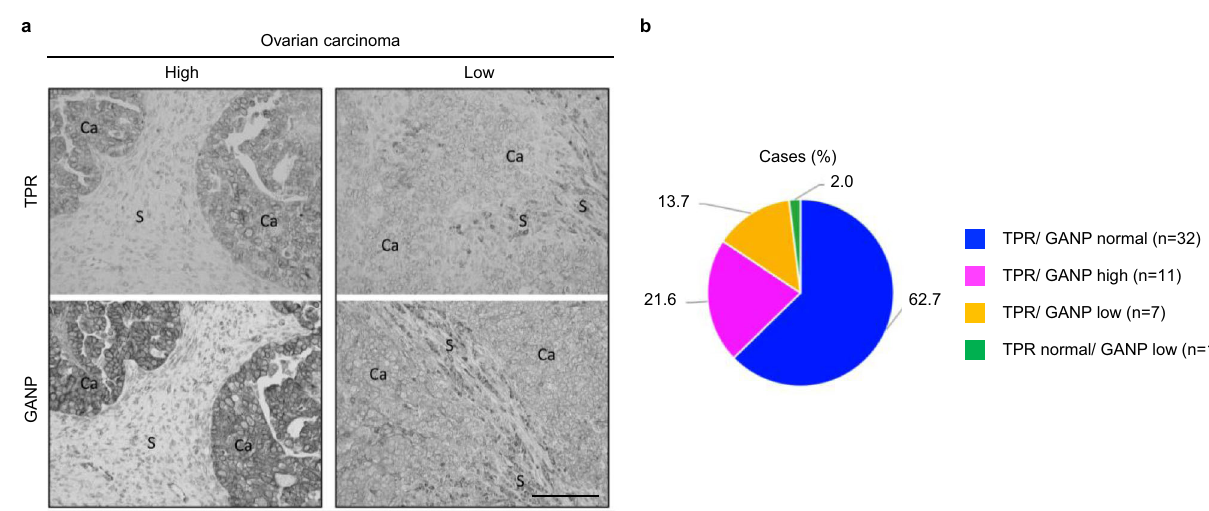
Fig. 6 Analysis of Tpr and GANP protein levels in human tumors. a Immunohistochemical analysis of Tpr and GANP protein levels on parallel sections of human tumors. Archival specimens from a cohort of 51 human serous ovarian carcinomas were stained with antibodies speci fi c for Tpr and GANP using immunoperoxidase technique. Examples of immunohistochemical staining patterns seen among the ovarian tumors are shown. The scale bar represents 100 µ m. b The summary of the scoring categories for the entire cohort of 51 human serous ovarian carcinomas